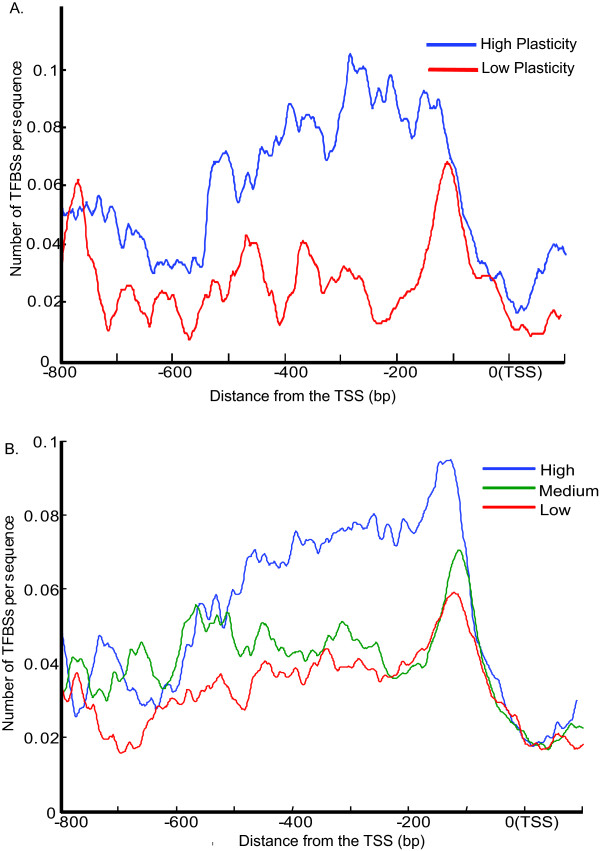
The distribution patterns of TFBSs among genes with different expression profiles. (A) High expression plasticity genes have distinct TFBS distribution patterns compared to the low plasticity genes. (B) The density of TFBSs has a positive correlation with gene expression level under rich media.